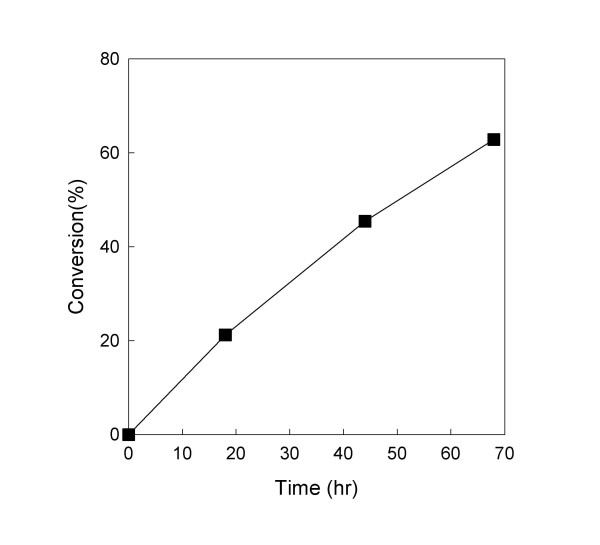
Synthesis of triacylglycerol by lipase displayed on the P. putida GM730/pJHC13 cell surfaces in the isooctane solvent reaction system at 37°C. Conversion yield during incubation is shown.